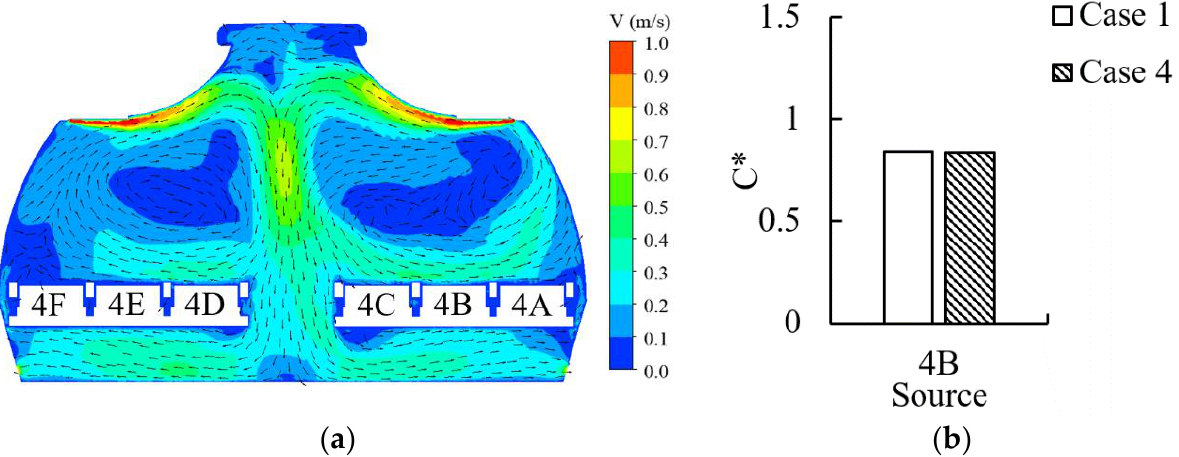
Figure 10. Airflow and normalized pollutant concentrations with all of the seats inclined in Case 4: ( a ) airflow field in the cross-section across the fourth row, ( b ) average pollutant concentration in respiratory zone of the 21 passengers seated in opposite to the half cabin with pollutant source.